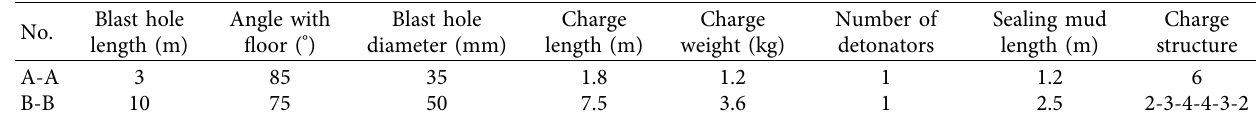
Figure 10: Integrated presplit blasting parameters. Section A-A shows the parameters for shallow hole blasting, and section B-B shows the parameters for roof cut blasting. The bottom picture shows the relative position of the two kinds blasting holes. Table 1: Presplitting blasting